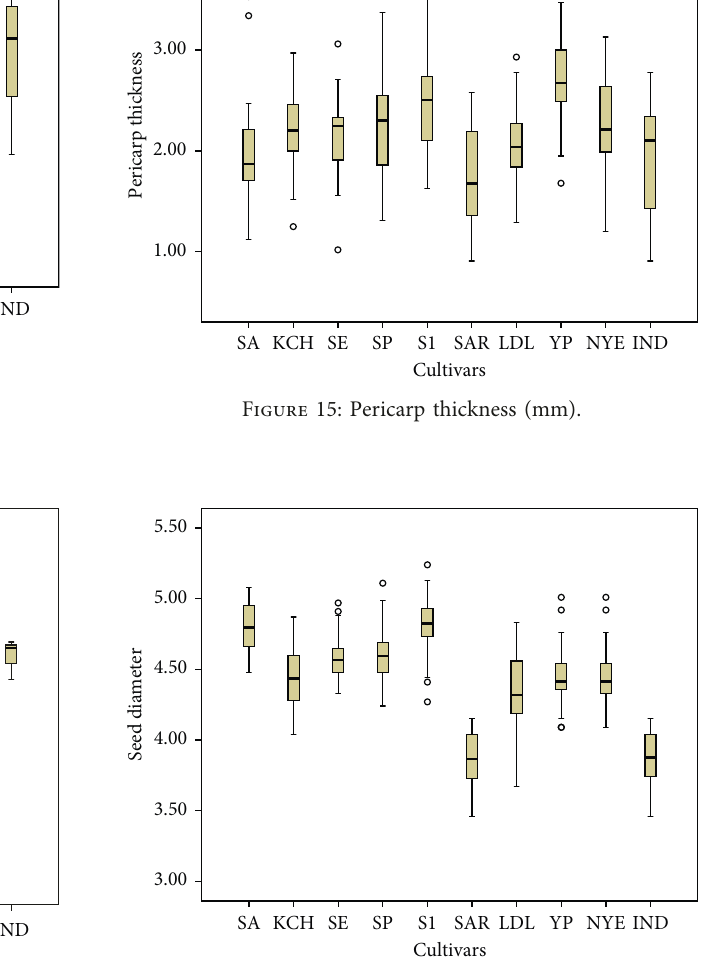
Figure 16: Seed diameter